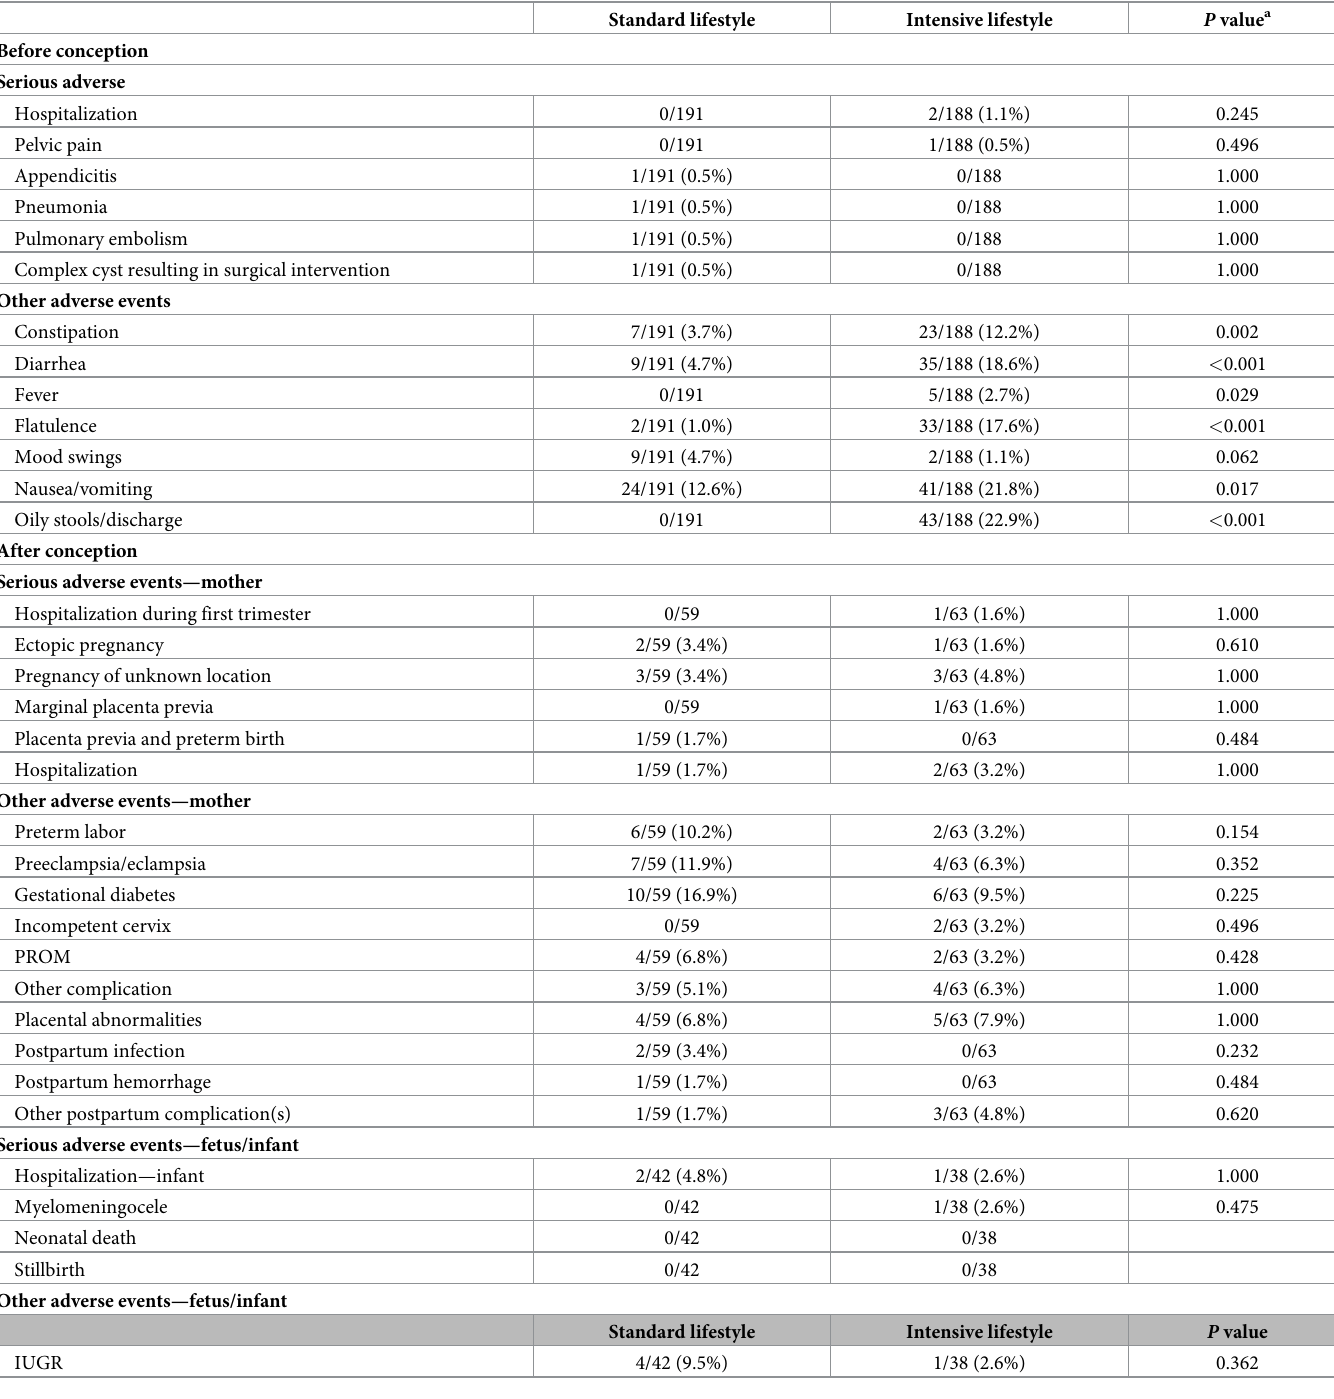
Table 4. Serious adverse events (all) and adverse events (with more than 2% of patients experiencing them) between the intervention